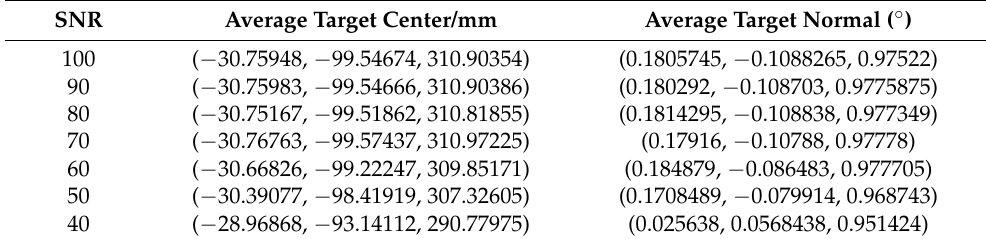
Table 3. Average space circular objective parameters after adding noise.